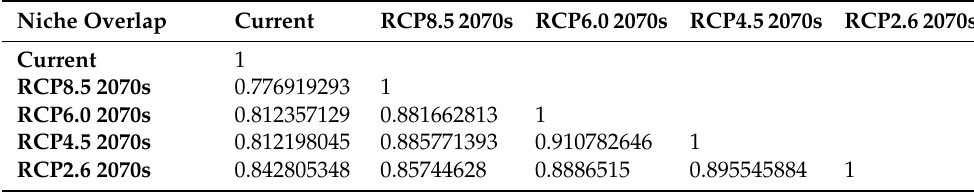
Table 4. Overlap of predicted suitable areas for Microplitis manilae under current and future